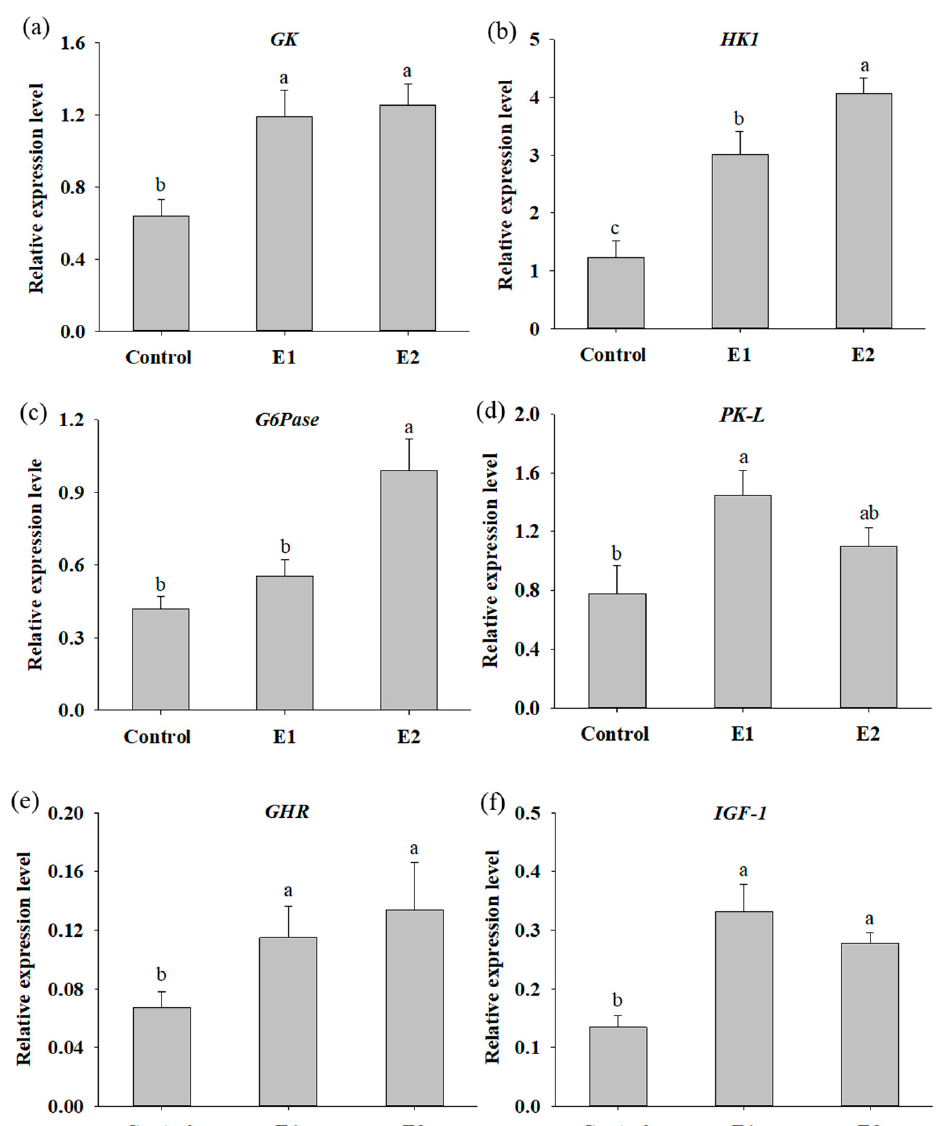
Figure 3. Relative mRNA expression levels of glucose metabolism genes in the livers of zebrafish fed the basal diet (control), the basal diet containing 10 6 CFU/g (E1) or the basal diet containing 10 7 CFU/g (E2) P. ehimensis NPUST1 for 8 weeks. ( a ) Glucokinase (GK); ( b ) hexokinase 1 (HK1), ( c ) gluco-6-phosphatase (G6Pase); ( d ) liver type pyruvate kinase (PK-L); ( e ) growth hormone receptor (GHR) and ( f ) insulin-like growth factor-I (IGF-1). The data are presented as the mean ± S.D. from six individual samples ( n = 6). Bars with different superscripts are significantly different ( p < 0.05).